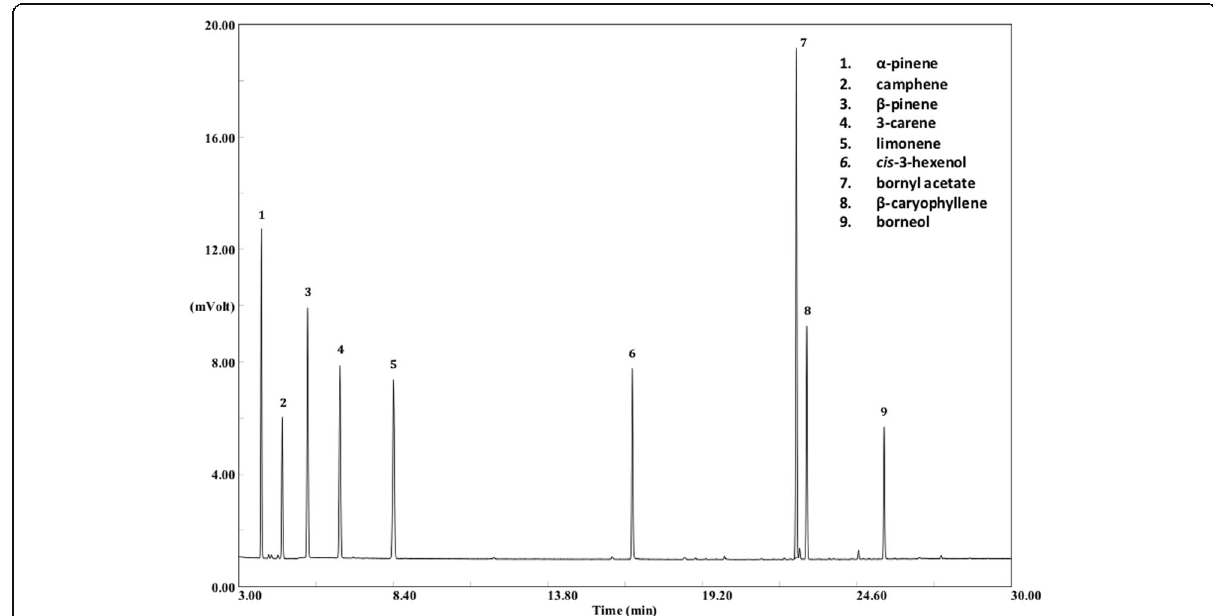
Fig. 1 Chromatographic profiles of GC-FID of Cal 3 showing the eight terpenes with the IS. The chemical structures are provided in